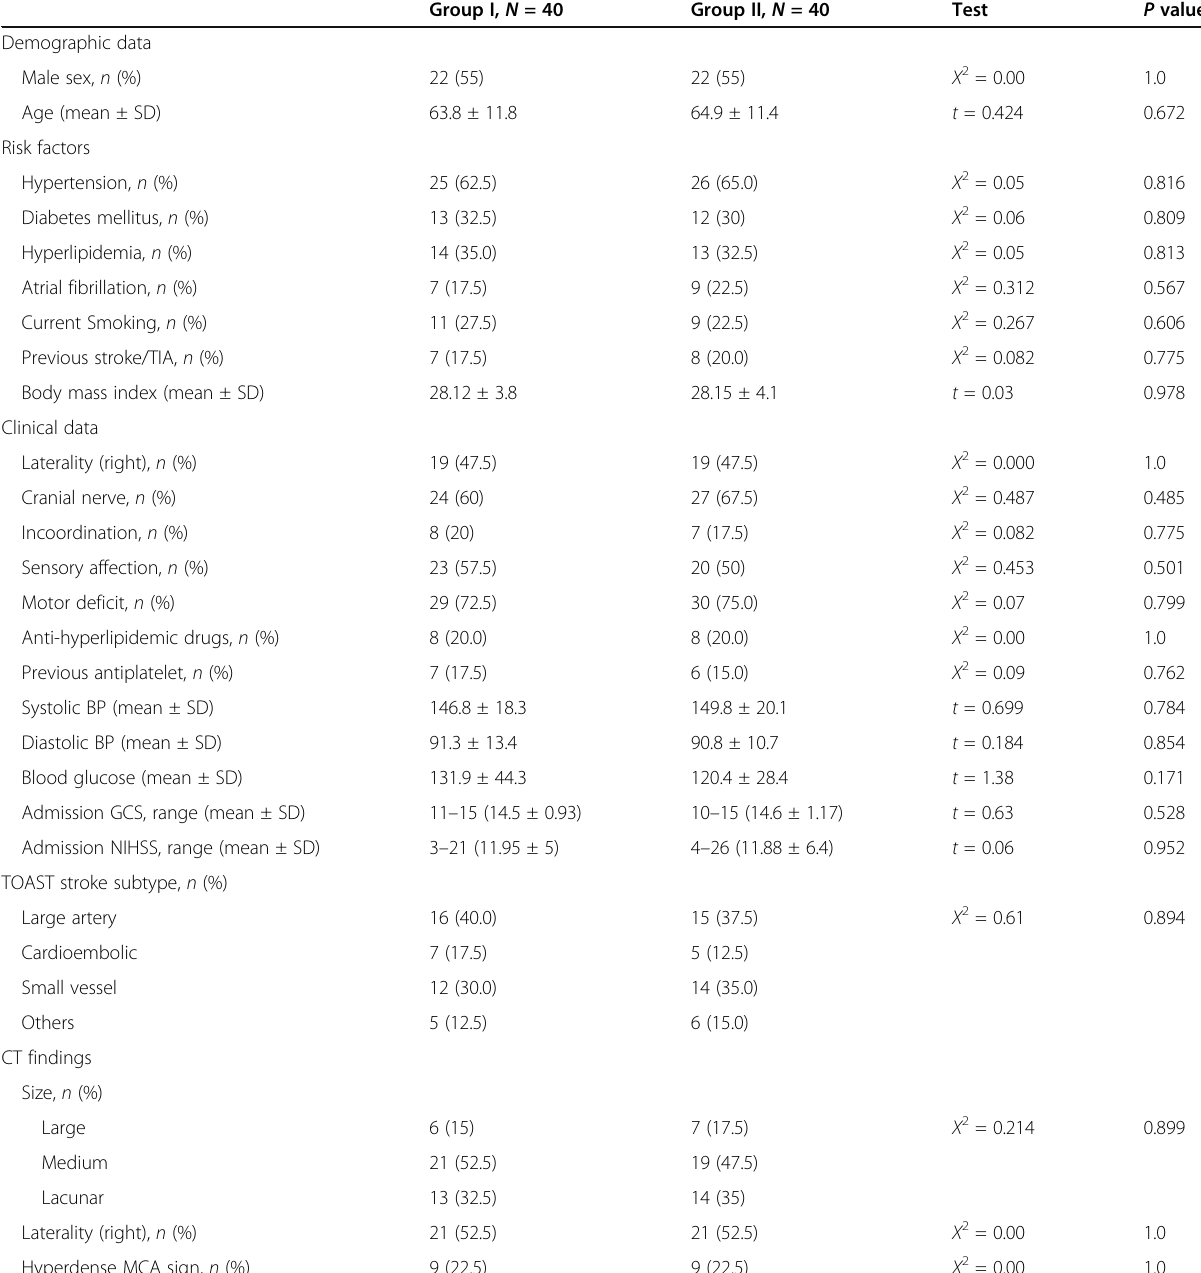
Table 1 Baseline characteristics of both studied groups Group I, N = 40 Group II, N = 40